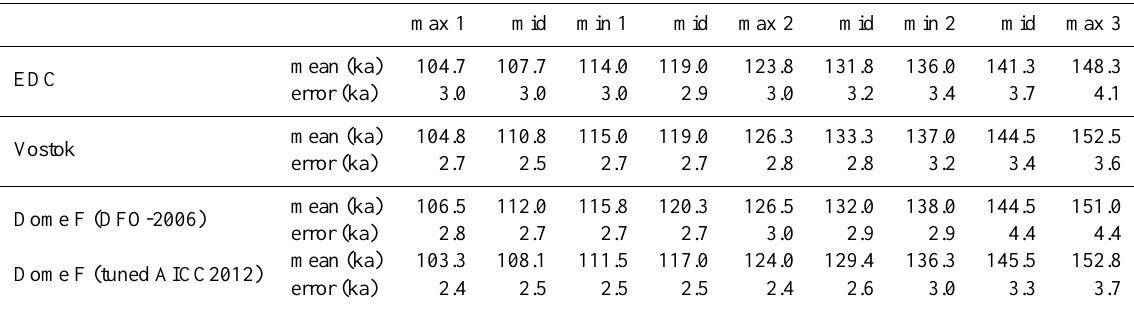
Table C1. Mean age and uncertainty calculated for minima, mid-slopes and maxima in the δ O 2 / N 2 records of EDC, Vostok and Dome F over MIS